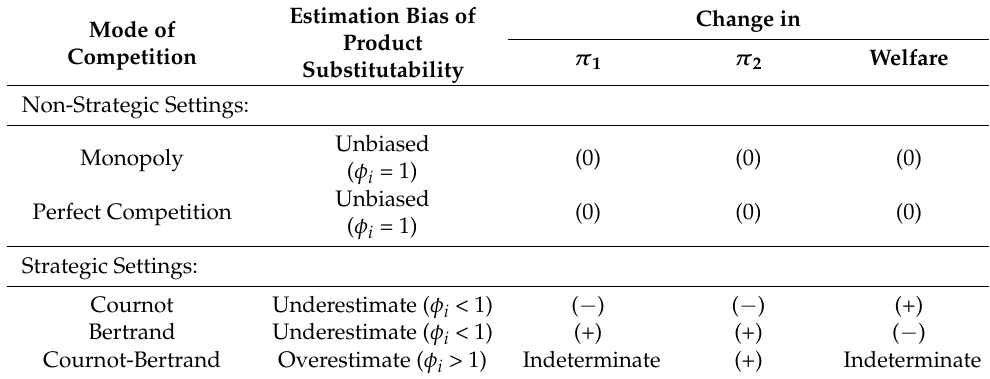
Table 5. The mode of competition, CEO estimation bias ( φ ), profit ( π ), and welfare (producer plus consumer